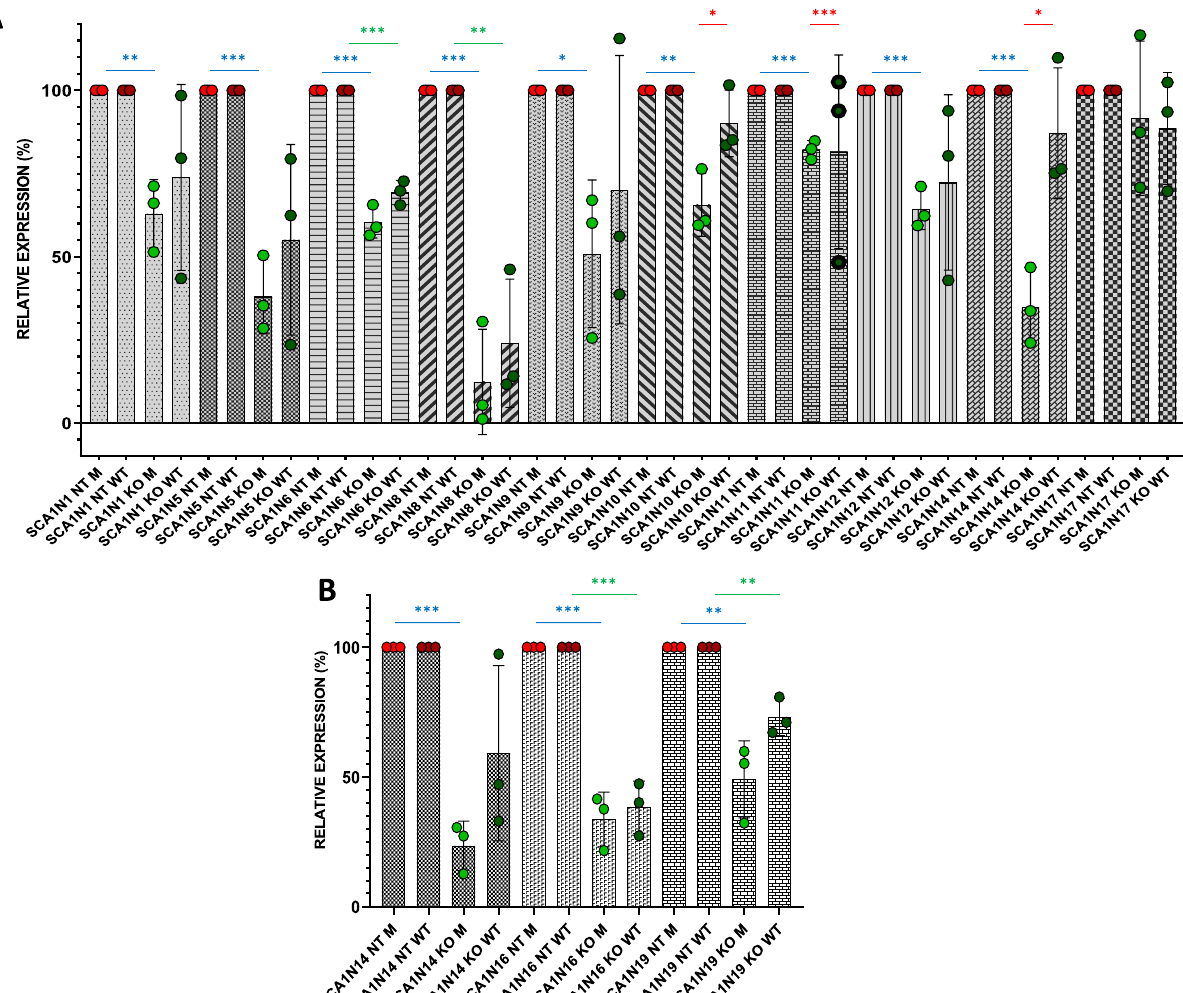
Figure 5. Effects of the CRISPR/Cas9 system on the differential expression of healthy and mutated ataxin 1 protein. Healthy and mutated ATXN1 protein expression was determined in SCA1 patient cells treated with both G3-G8 ( A ) and G3N-G8N ( B ) sgRNAs complexed with Cas9 endonucleases. The bands produced by the two forms of ataxin 1 obtained following Western Blotting analysis were separately quantified by densitometry and both normalized on the total amount of proteins. Values are mean ± s.e.m. from three independent experiments. The statistical test used was unpaired t test with two-tailed P value and alpha level P < 0.05. *p < 0.05; **p < 0.005; ***p <